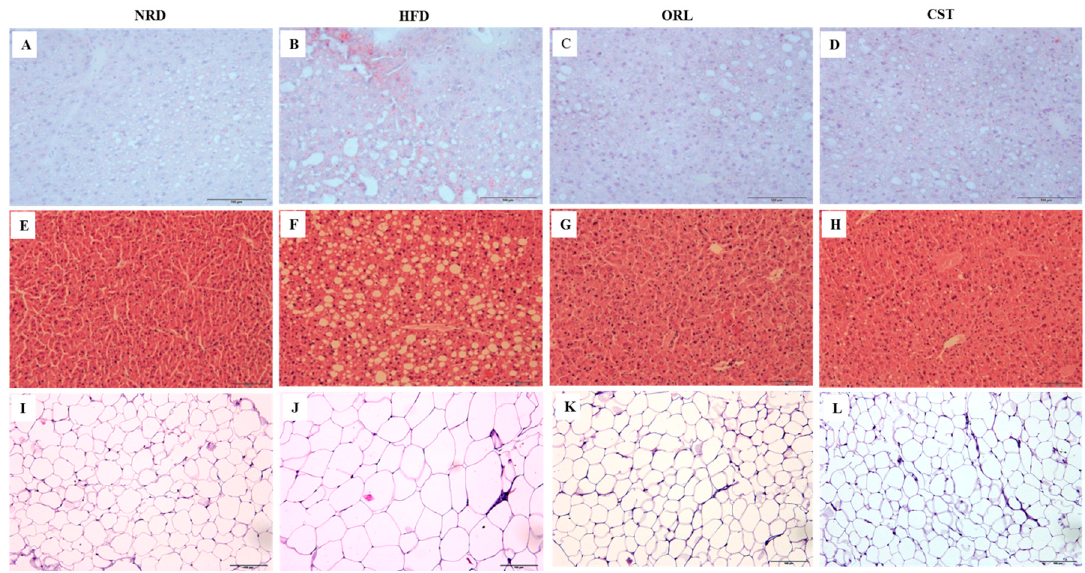
Figure 3. Histopathology of liver and adipose tissues: Frozen sections of the liver tissues stained with oil-O-red ( A – D ) and counter stained with hematoxylin and eosin (H & E) ( E – H ); Paraffin sections of fat tissues stained with H & E ( I – L ). The histological examinations of the tissue sections were performed under light microscopy with 200× magnification (scale bar 100 μ m).